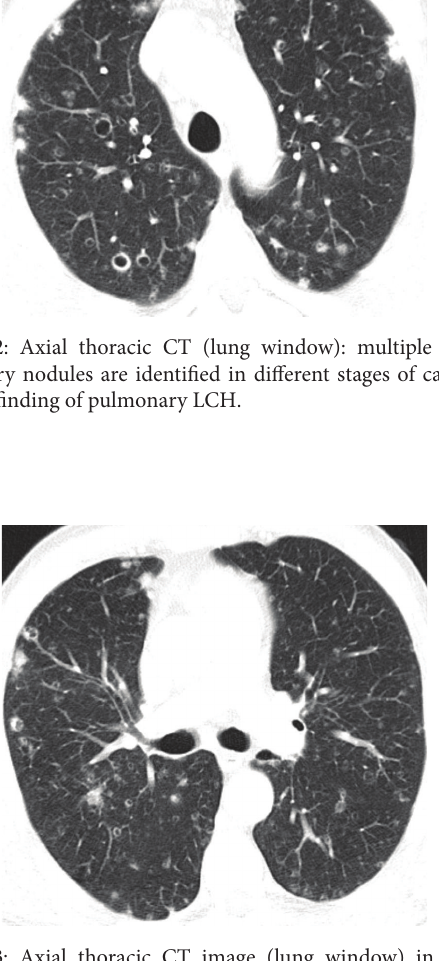
Figure 3: Axial thoracic CT image (lung window) in a lower thoracic CT slice: less nodules are identified. Note the normal appearance of the lung parenchyma other than the nodules.